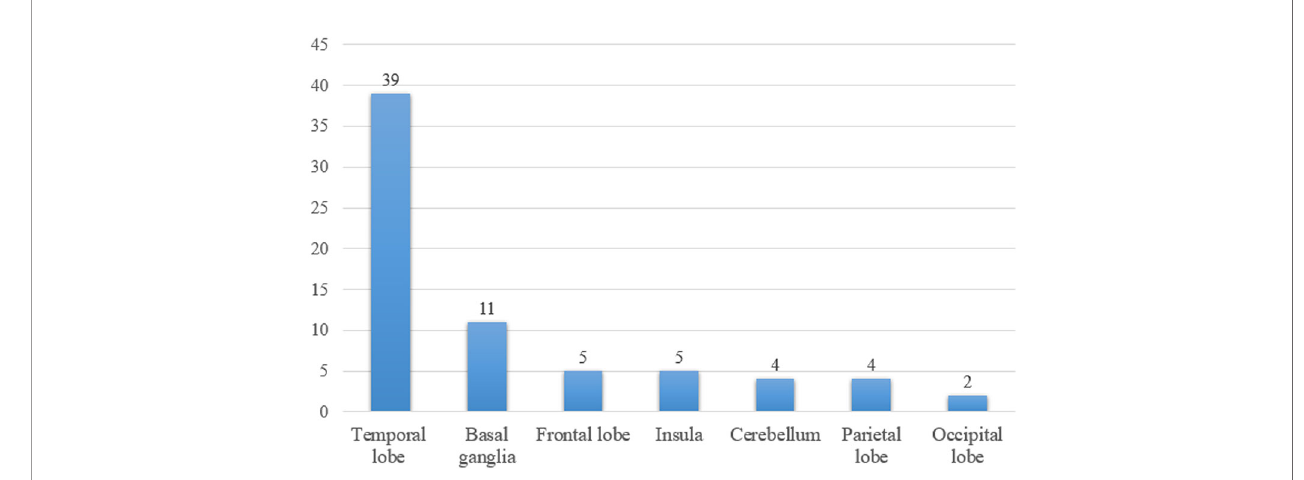
FIGURE 1 | The number of patients with T2/ fl uid-attenuated inversion-recovery hyperintensity lesions in different brain